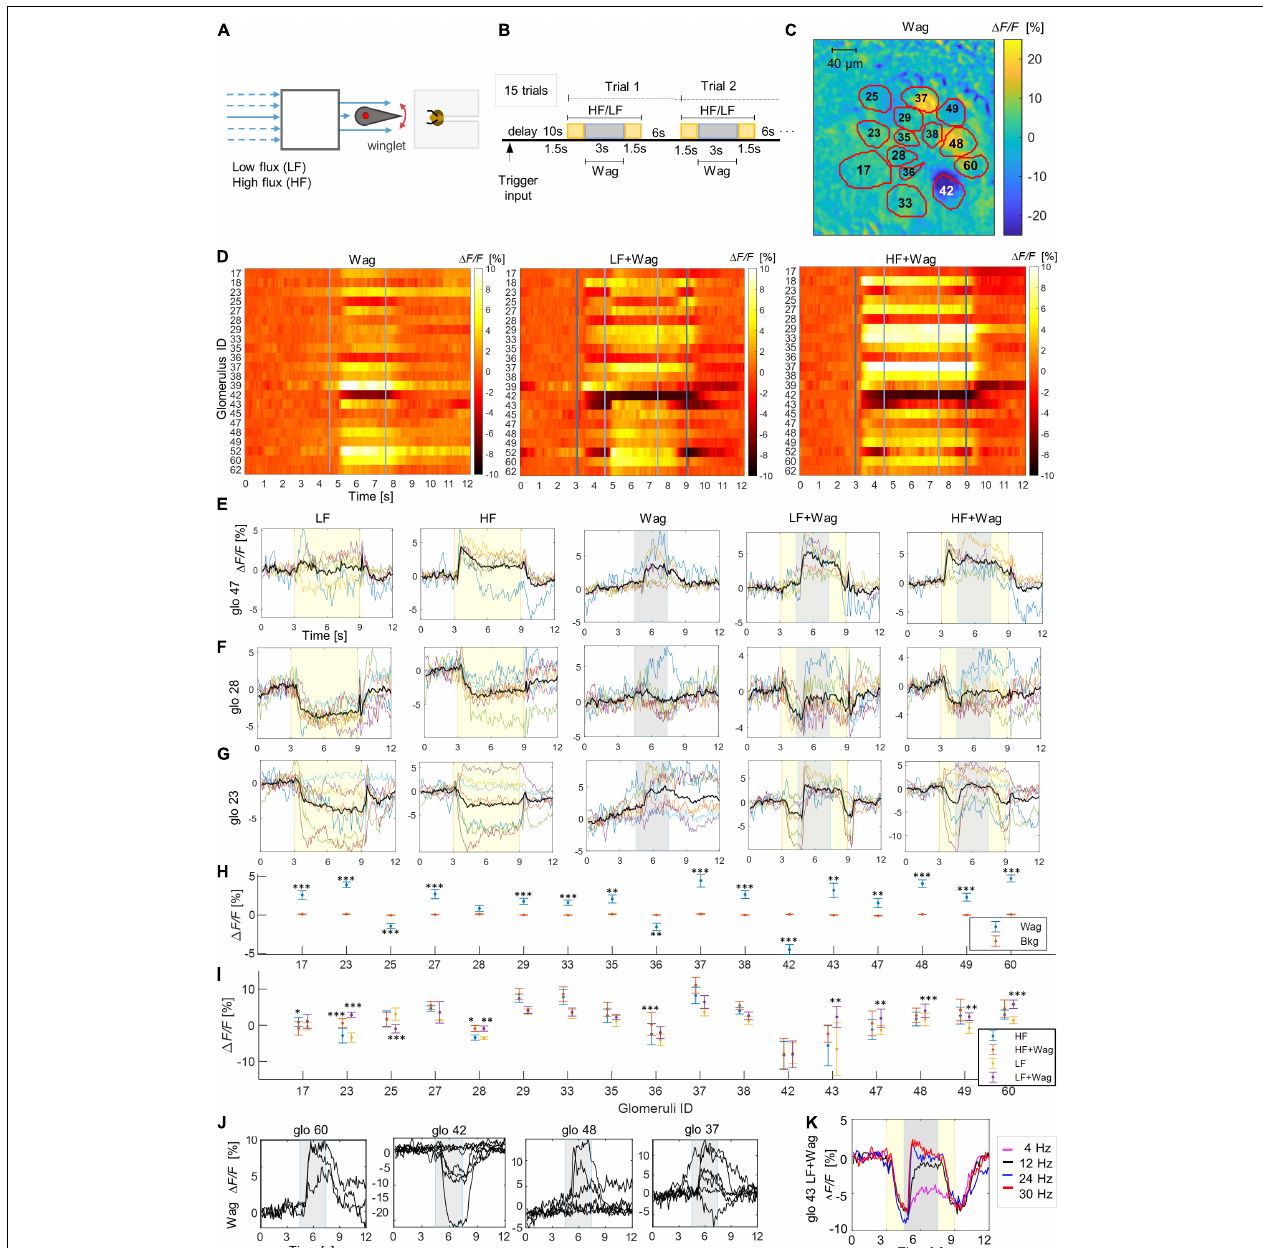
FIGURE 3 | Response patterns to waggle motion. (A) Stimulus generator scheme for laminar airflow and waggle-dance-like stimuli via an oscillating winglet. (B) Stimulation protocol with laminar flow stimuli starting after 10 s of background acquisition, lasting 6 s (yellow area) and a waggle motion added to it after 1.5 s lasting 3 s (gray areas), inter-stimulus interval 6 s. (C) Relative fluorescence change in the imaging plane during stimulus only by the waggle motion (Wag) without additional airflow, outlines and labels show the identified glomeruli. (D) Heatmaps show the subject-averaged glomerular responses to the waggle only stimulus (Wag) and combined stimuli where waggling is added after 4.5 s to the low flux (LF + Wag) or the high flux (HF + Wag). (E) Temporal response curves to single and combined stimuli of glomerulus 47 which is sensitive already to waggling only. (F) Temporal response curves to single and combined stimuli of glomerulus 28 which is not sensitive to waggling only, where waggling stronger modulates the LF stimulus. (G) Temporal response curves to single and combined stimuli of glomerulus 23 sensitive to waggling and where waggling stronger modulates the HF stimulus. (H) Mean values and standard errors across trials and bees of the glomerular responses during the central 3 s of a waggling only stimulus with respect to the background signal. Significant differences between waggling and the background signal are marked with ∗ p < 0.05, ∗∗ p < 0.01, ∗∗∗ p < 0.001. Full statistical results are shown in Supplementary Table 4 . (I) Mean values and standard errors across trials and bees of the glomerular responses during the central 3 s of the two airflow strength signals with and without additional waggling (blue: high flux only, red: high flux and waggling, yellow: low flux only, violent: low flux and waggling). Significant differences between air only and air + waggling are marked with * p < 0.05, ** p < 0.01, *** p < 0.001. Full statistical results are shown in Supplementary Table 5 . (J) Temporal response curves of 4 selected glomeruli to waggle motion only. (K) Response of a selected glomerulus to a low flux stimulus with superimposed waggle motion at different